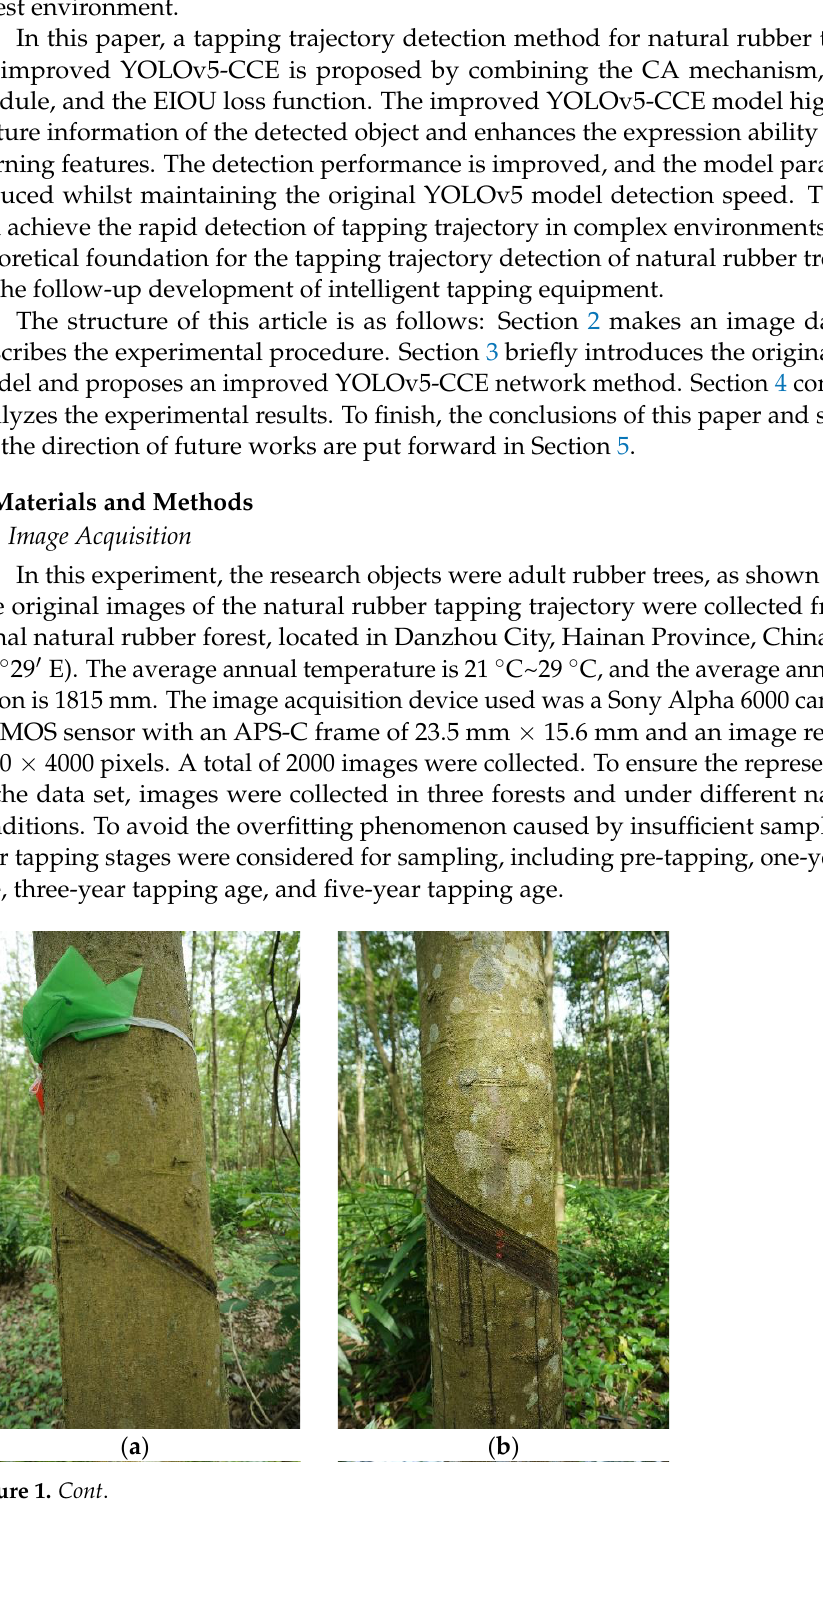
( d ) Figure 1. The original images of natural rubber tapping trajectory. ( a ) Pre-tapping, ( b ) One- year tapping age, ( c ) Three-year tapping age, ( d ) Five-year tapping age. 2.2. Image Enhancement Training object detection models based on deep learning require a great deal of image data. In this paper, in order to obtain an abundant data set to better extract image feature information and enhance the generalization ability of the model, multiple enhancement operations were performed on the described original images, including rotation, random translation, adding noise, adjusting saturation, and adjusting brightness, as shown in Fig- ure 2. Random translation and adding noise can improve the detection performance and robustness of the network. Adjusting saturation and brightness can eliminate the impact of brightness bias due to ambient lighting changes and sensor differences on network per- formance. A total of 5000 new samples were obtained after data enhancement. The images were then randomly divided into a training set, test set and validation set according to 8:1:1 for network training and parameter verification, to avoid overfitting of the training model. In addition, according to the shape of the rubber tapping trajectory, Labeling Im- age Annotation software was used to annotate the data set and generate the correspond- ing label files to ensure the accuracy of the parameters.